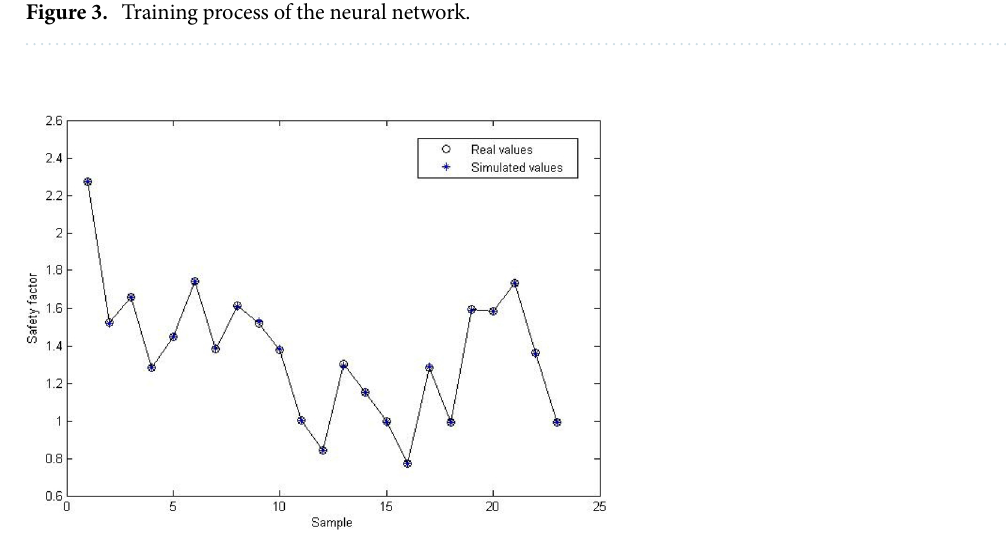
Figure 3. Training process of the neural network.